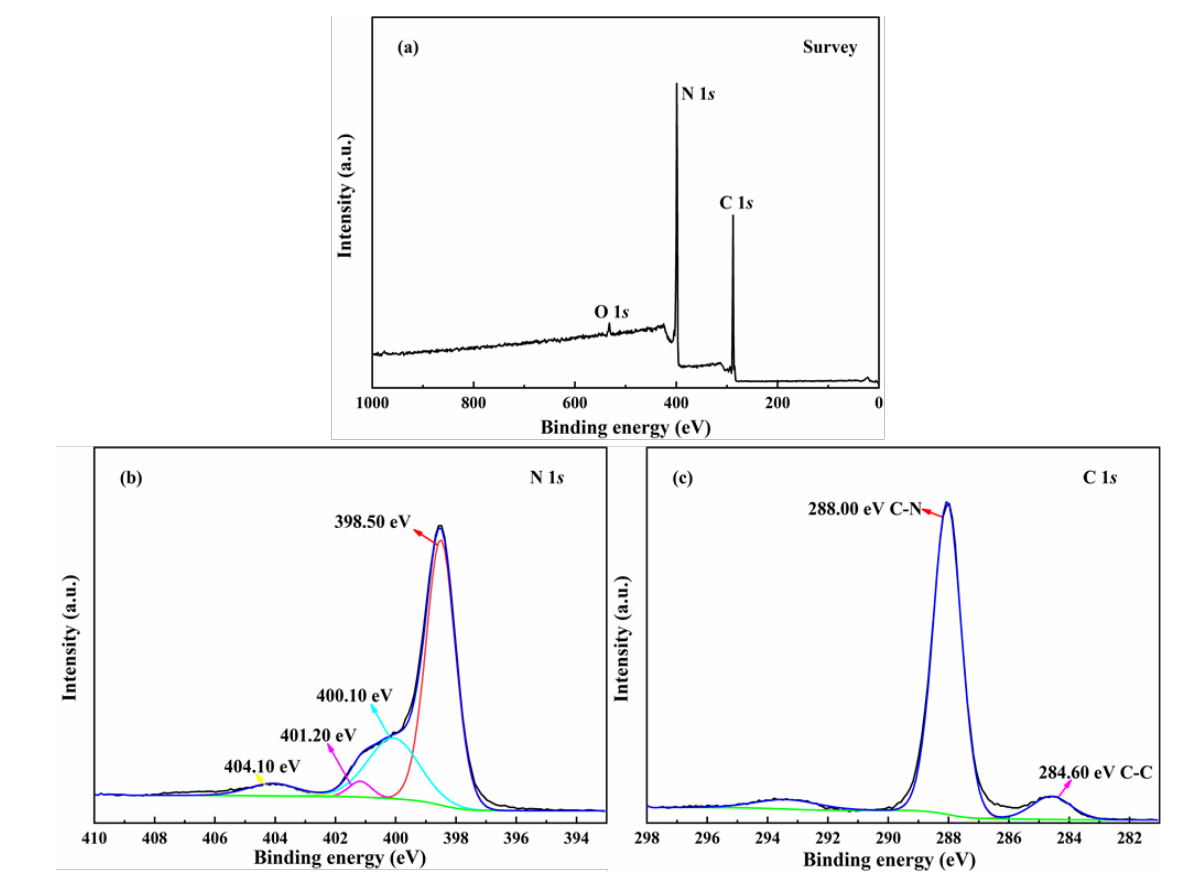
Figure 3. XPS spectra of CN-700 sample: ( a ) XPS survey; ( b ) N1 s spectra; ( c ) C1 s spectra.